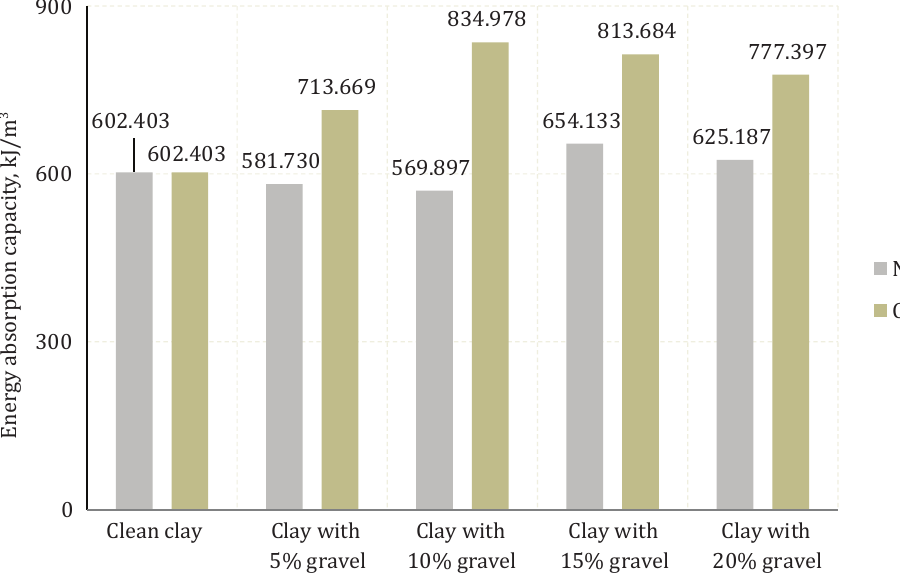
Figure 7. Enegry absorption capacity of the